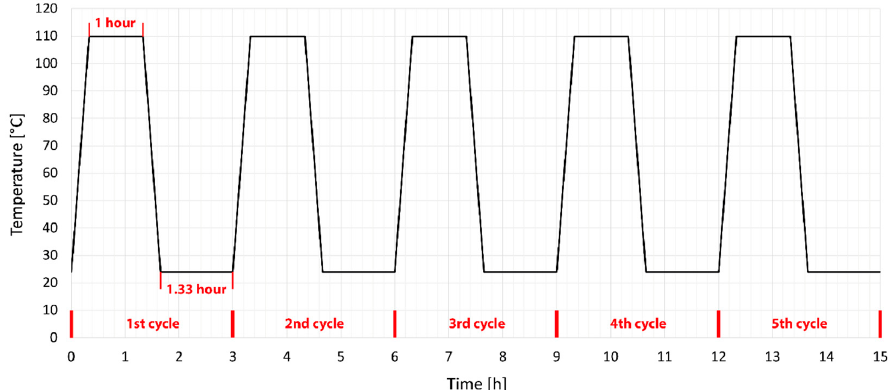
Figure 2. Setting temperature ageing cycle of HDPE under the melting point.